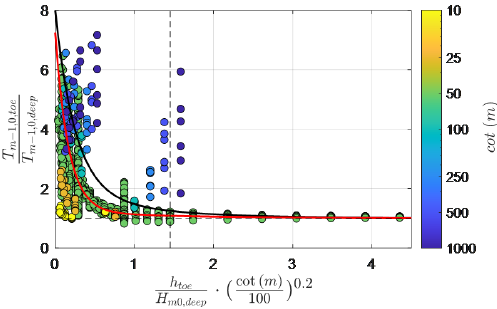
Figure C1. Numerically modelled relative spectral wave period as a function of relative water depth and foreshore slope, follow- ing Hofland et al. (2017). Black and red lines represent Eqs. (C1) and (C2), respectively.